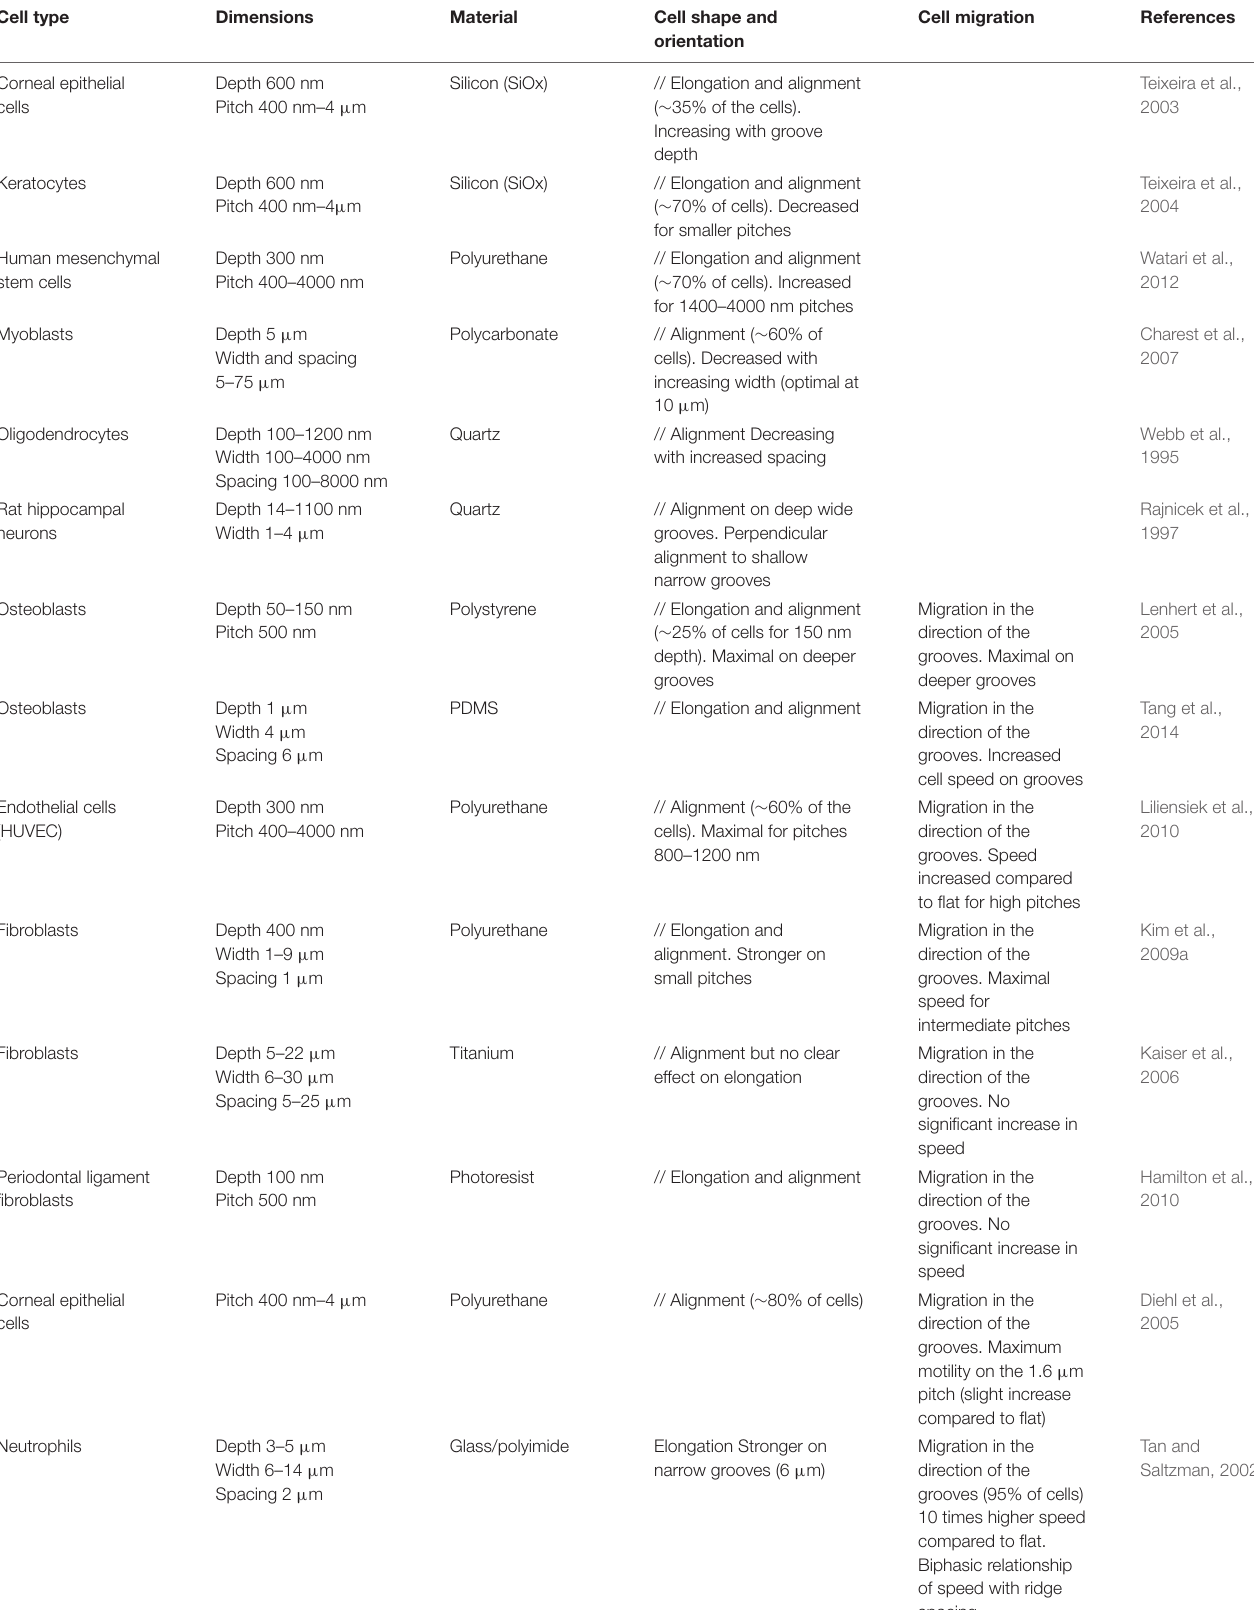
TABLE 1 | Effect of grooved substrates on cell alignment and